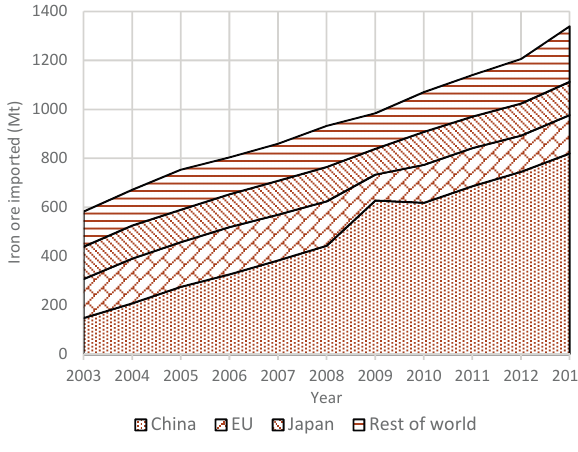
Figure 4. Major importers and world imports of iron ore